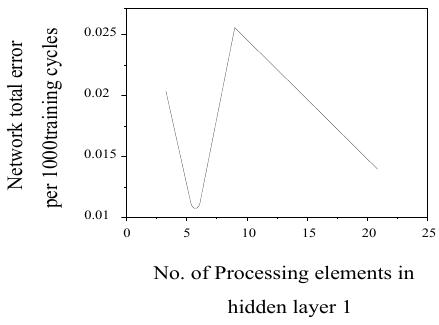
Fig. (2) Selection of Optimum Number of Hidden